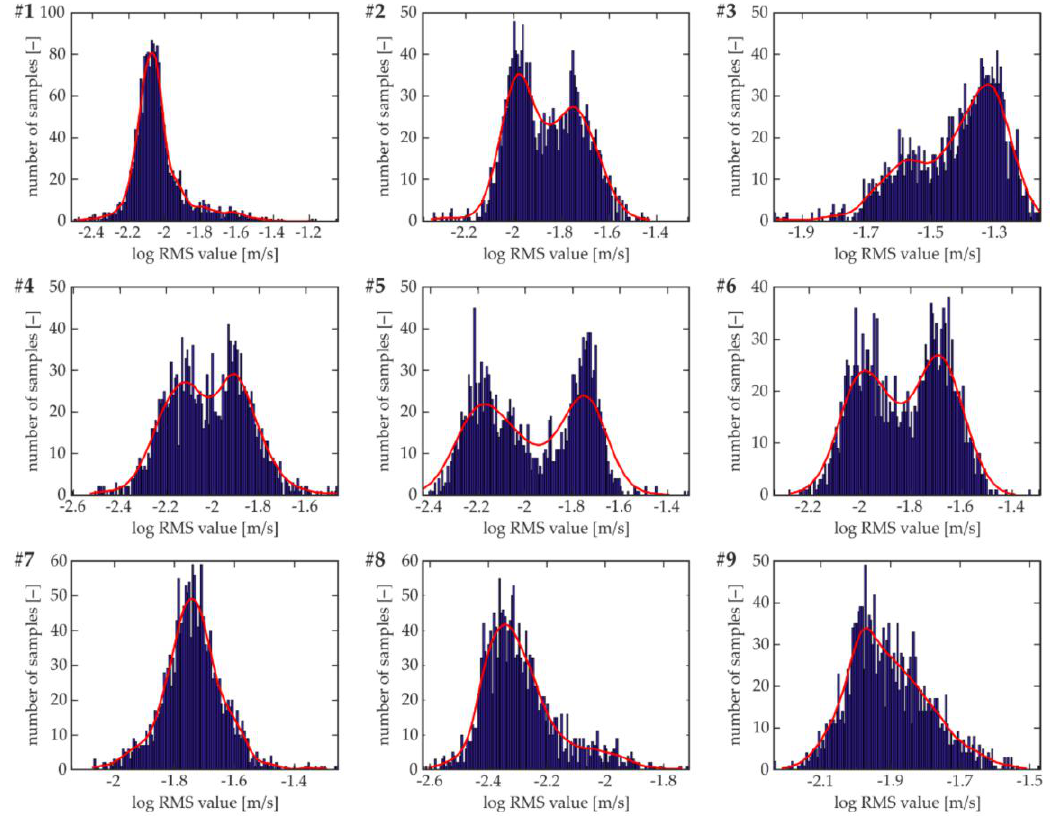
Figure 16. Histogram of WRMS values for specimens #1–#9 ( T = 3.00 ms, w r = r